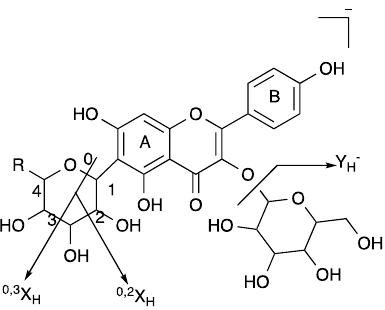
Figure 6. Mass spectrometric analysis of flavonoid glycosides in negative ion mode. Compounds 1 , 2 , 7 , 10 , and 11 were all flavonoid oxygen glycoside compounds [38]. Quasi-molecular ion peaks can appear in negative ion modes of flavonoid oxygen glycoside compounds to cause glycosidic bond cleavage. This is characterized by a neutral loss of the glucosyl C 6 H 10 O 5 (162), rhamnosyl C 6 H 10 O 4 (146), or xylose C 5 H 8 O 4 (132). The aglycon structure can continue to lose -CH 3 and -CO 2 or RDA cleavage can occur in the C ring of the flavonoid aglycon. The MS spectrum of Compound 1 (t R = 10.22 min) showed an [M − H] − ion at m / z 771.2027, and the fragment ions of oxygen glycosides: m / z 609.1530, 462.0838, and 301.0357 were generated. Compound 1 was identified as quercetin 3- O -hexobioside-7- O - hexoside [39]. Compound 10 (t R = 14.34 min) showed an [M − H] − ion at m / z 463.0890. According to m / z 301 [M-162-H] − secondary mass spectrometry, we speculated that there was glucose in the structure of the compound, and the molecular weight of the parent nucleus was 301, which was quercetin. Based on Scifinder and Reaxy database retrieval, Compound 10 was presumed to be quercetin 3- O -hexoside [40]. Compound 1 and Compound 10 had the same mass spectrum fragmentation pathway. The relative molecular mass of Compound 10 was 464. The fragment ion peak ( m / z 301) was caused by the loss of a quasi-molecular ion peak and a neutral fragment of m / z 162. According to the relative molecular mass, the neutral fragment of m / z 162 was preliminarily judged to be a glucose group. Since [M-H-162] − ( m / z 301) is a fragment ion of quercetin aglycone, this indicates that there was a glucosyl group in the compound. The fragmentation of m / z 301 ion generated two main characteristic ions: m / z 179 and m / z 151. The m / z 179 may be obtained by the fragmentation of m / z 301 and the transfer of 2 H ions. The m / z 151 fragment ion was generated by the RDA reaction of m / z 301. In addition, the loss of one molecule of CO at m / z 179 also generated m / z 151 ions. This is consistent with the cleavage pathway for quercetin 3- O -hexobioside quercetin aglycon fragment ions, and the cleavage law conformed to the structural characteristics of quercetin 3- O -hexoside. Compound 2 (t R = 11.59 min) showed an [M − H] − at m / z 365.0881 and product ions at m / z 203.0352, 159.0454, and 130.0422. Among them, m / z 203.0352 represented [M-H-C 6 H 10 O 5 ] − obtained after the precursor ion lost glucose, which is the aglycon of the compound. The m / z 159.0454 represents the fragment ion obtained after the precursor